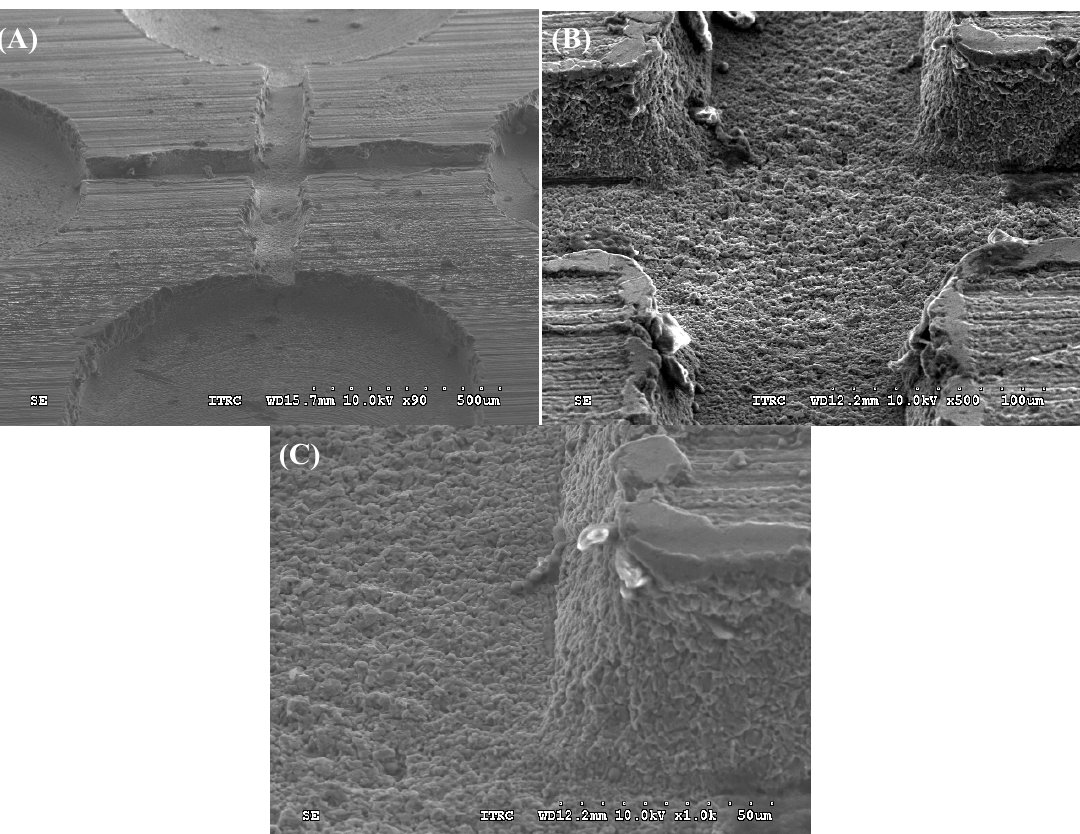
Figure 3. SEM photos of the aluminum microfluidic device. ( A ) Microchannels, ( B ) cross-junction, and ( C ) side channel